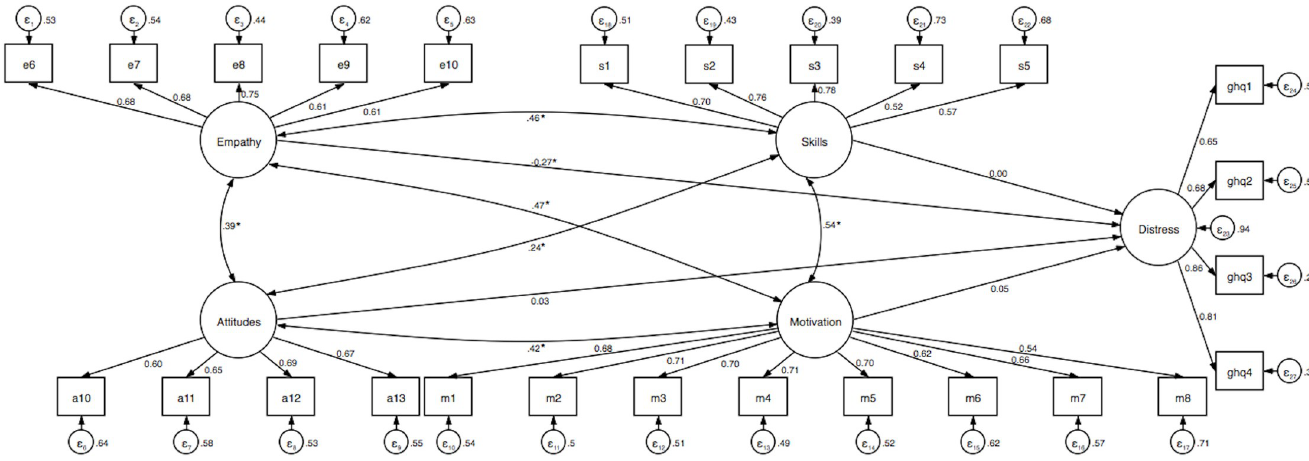
Fig 2. Structural equation model examining the association between cross-cultural competence and psychological distress. Standardized coefficients are reported and the significance levels of paths and covariates presented here are for the standardized regression coefficients. Model adjusted for gender, age, employment sector, and frequency of interacting with patients and colleagues from different cultures. Goodness-of-fit indices: χ 2 (289) = 1168.29, p < .001, RMSEA = 0.06, CFI = 0.89, SRMR = 0.05 (index obtained from the estimation of goodness-of-fit of the model tested with the maximum likelihood, n = 819). R 2 distress = 5.6%. � p <